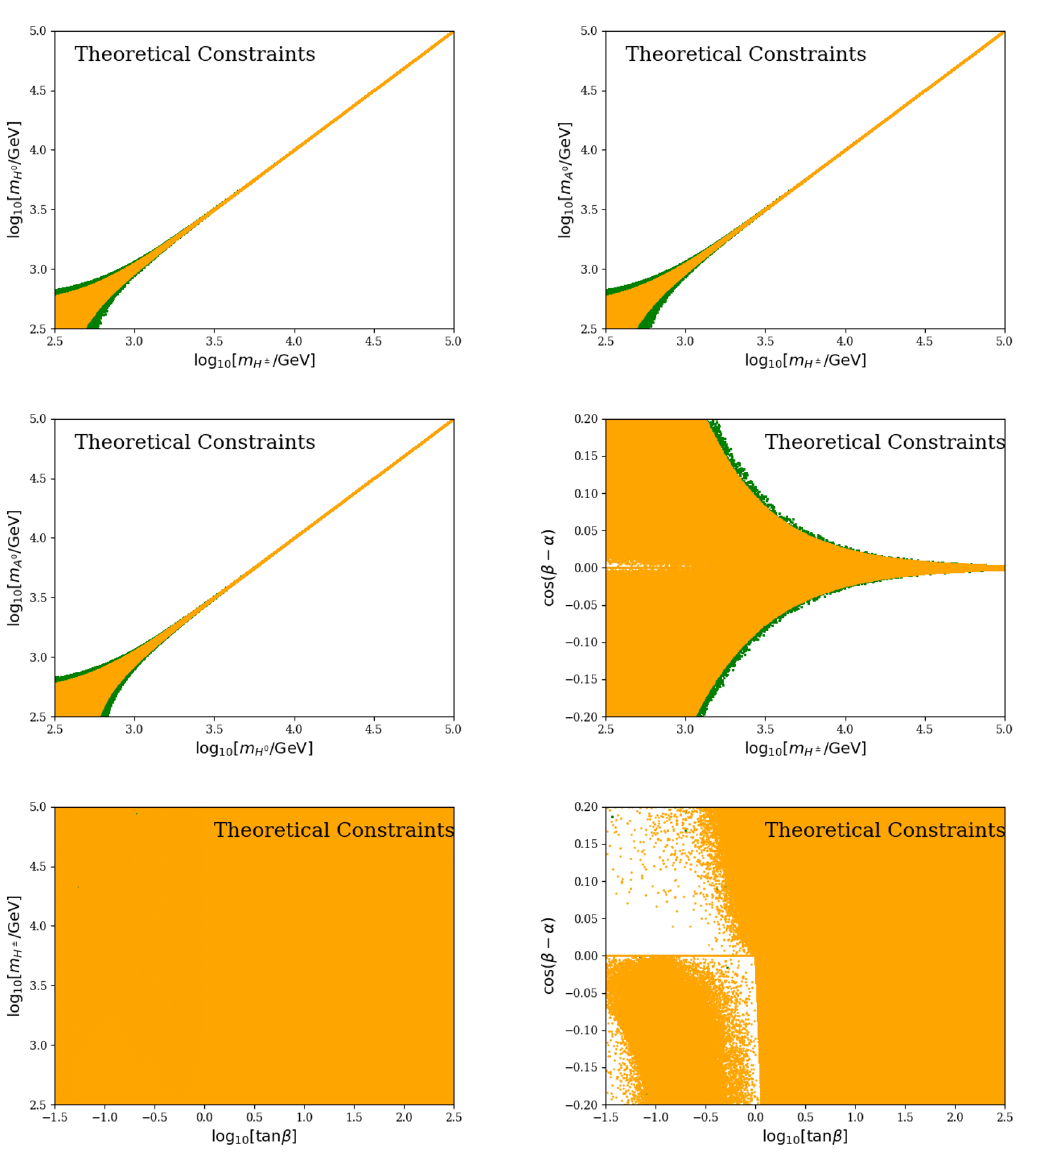
, m and m , tan β and cos( β − α ) stemming H 0 A 0 H +